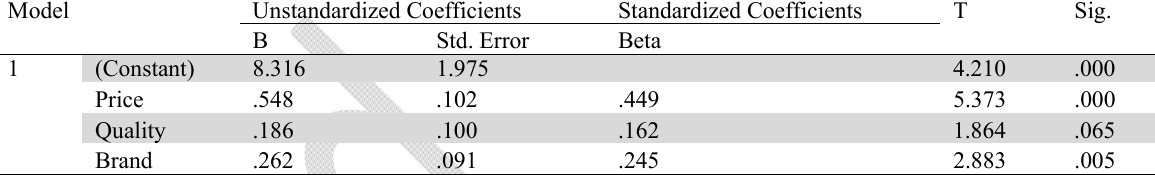
Model 1 Multiple Linear Regression Test Results (Coefficients a ) Model Unstandardized Coefficients Standardized Coefficients